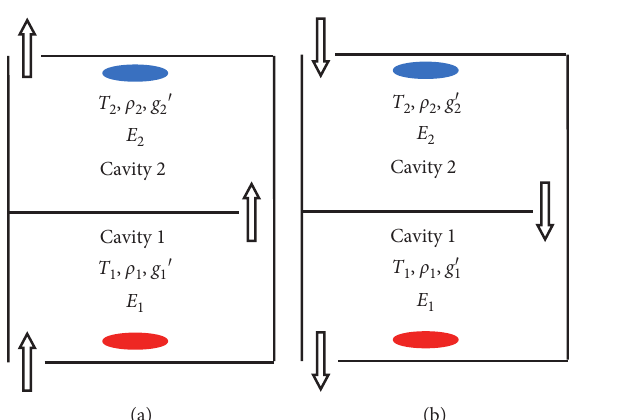
Figure 2: Two vertically connected cavities with a top opening and a bottom opening. (a) An upward flow pattern. (b) A downward